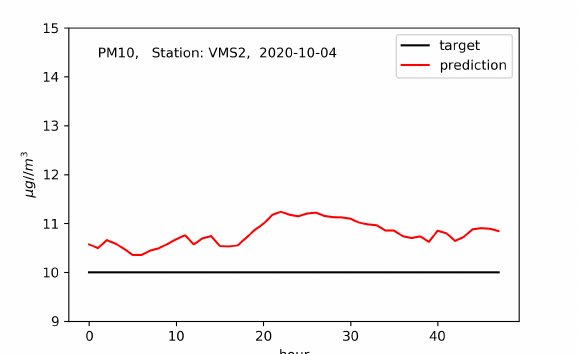
Figure 9: prediction of PM 10 near the minimum detection (L1- Loss: